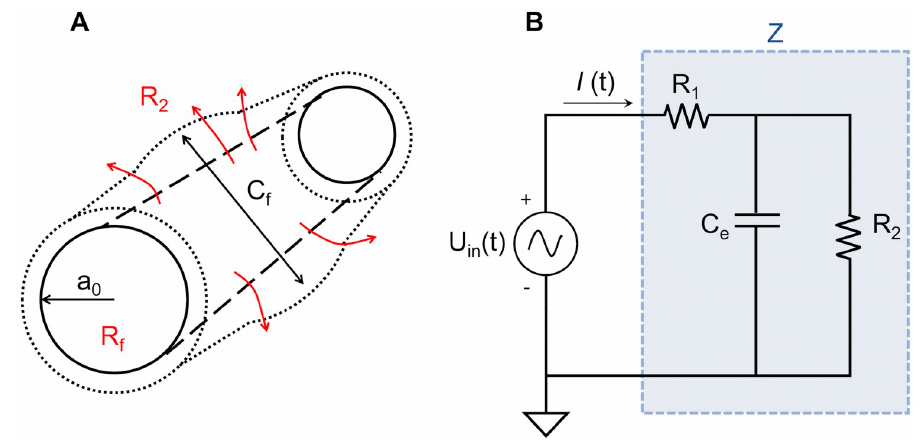
Fig 8. Schematic of a three-element Windkessel equivalent circuit. A) Schematic drawing of a tube segment of an internal vein. a 0 = radius, C = fluidic capacitance, R = fluidic resistance. R 2 = leakage due to permeable ‘walls’. B) f f Schematic drawing of RC circuit. The blue box (denoted with Z) represents the impedance of one singele 3-element Windkessel (see Fig 9). U ( t ) = input voltage signal, R 1 = resistance due to internal friction of the cytoplasm, R 2 = in resistance due to leakage through vessel wall, C e = electric capacitor, I = current.